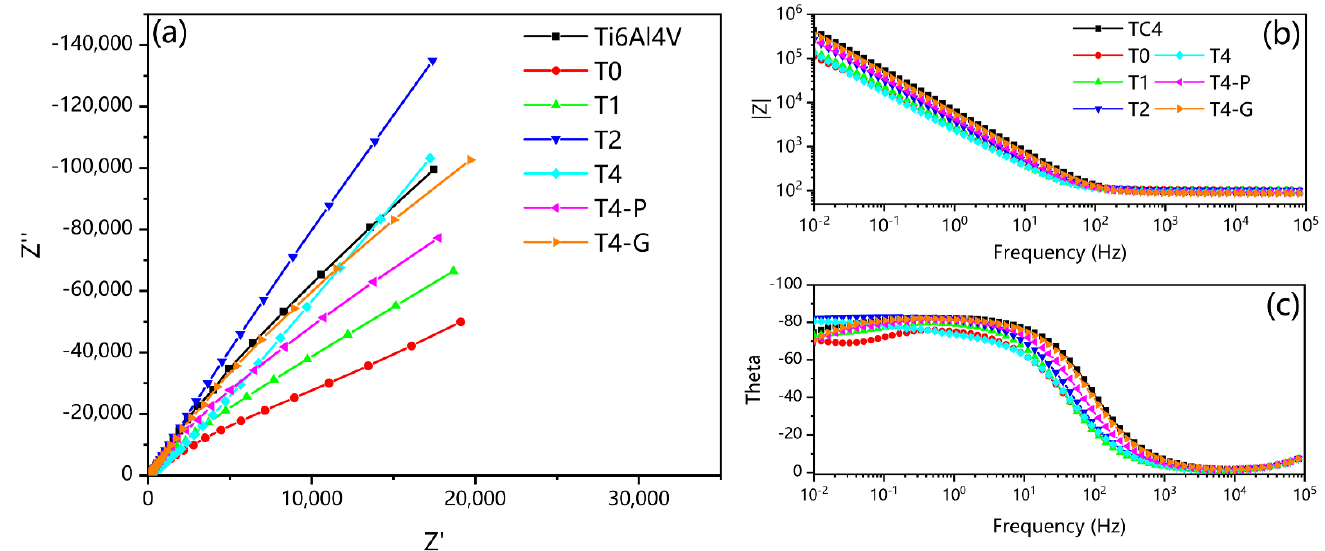
Figure 12. Images of EIS curves for untreated Ti6Al4V, nitriding, and mechanically treated samples: ( a ) Nyquist plots: The impedance arc radius represents the corrosion resistance of the specimen. Overall, for the nitriding samples of different times, the thicker the nitriding layer is, the better the corrosion resistance is; ( b , c ) Bode plots: the high-er |Z| values in the low-frequency region and wider theta peak widths in the mid-frequency region suggest better corrosion resistance.